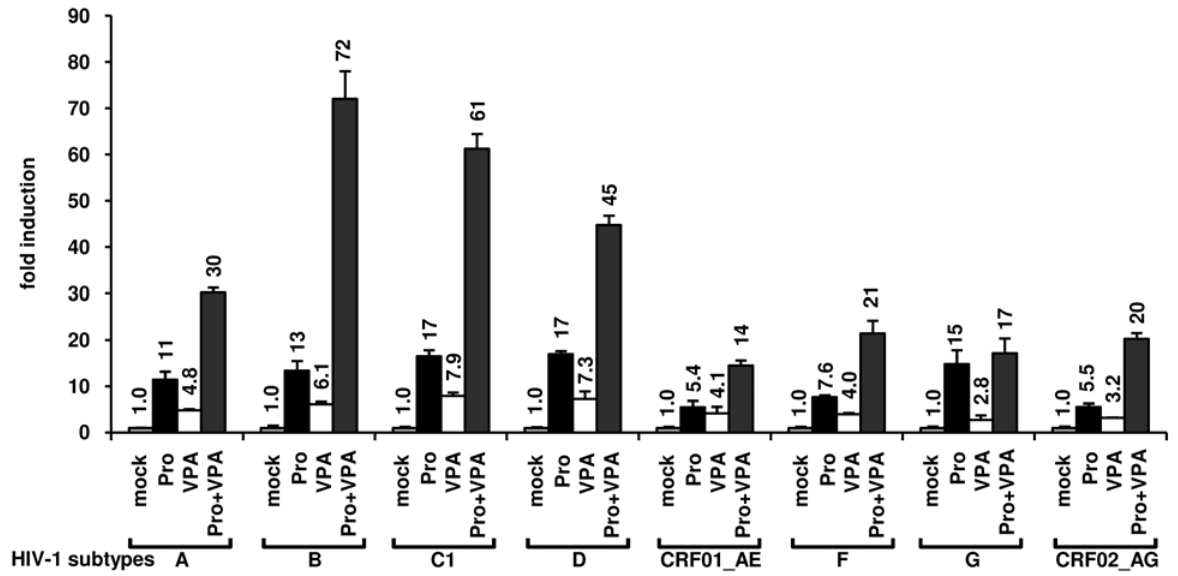
Figure 4. Effect of prostratin + VPA on transcriptional activity of LTRs from several HIV-1 major (M) group subtypes. Jurkat cells were transiently transfected with LTR-luciferase reporter constructs (LTRs from subtypes A, B, C1, D, CRF01_AE, F, G, CRF02_AG). At 20 h posttransfection, transfected cells were mock-treated or treated with prostratin (5 m M), VPA (2.5 mM), or prostratin + VPA. At 42 h posttransfection, cells were lysed and assayed for luciferase activity. Luciferase activities derived from the HIV-1 LTRs were normalized with respect to protein concentration using the Detergent-Compatible Protein Assay. Results are presented as histograms indicating inductions by the compounds (in fold) with respect to the basal activity of each pLTR-luc construct, which was assigned a value of 1. Each value is the mean 6 SE from two separate experiments performed in triplicate.